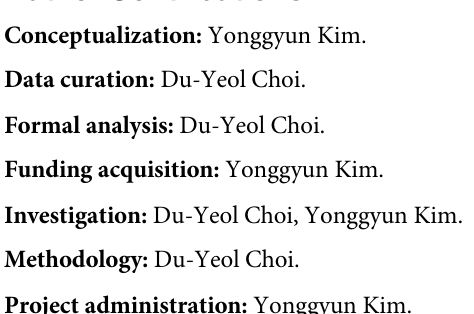
S3 Table. Annotation of 68 genes expressed only at 60 h after adult emergence (AAE) com- pared to expression levels at the early (0 h AAE) developmental stage in female F. occiden- talis adults. S4 Table. Highly ( > 8-fold) suppressed genes at mid (36 h after adult emergence) and late (60 h after adult emergence) ovarian development stages compared to expression levels in the early (0 h after adult emergence) developmental stage in female F. occidentalis